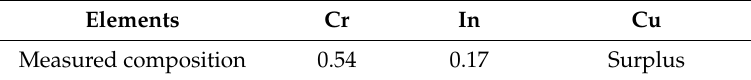
Table 1. Measured composition of as-cast Cu–Cr–In alloys (wt.%).